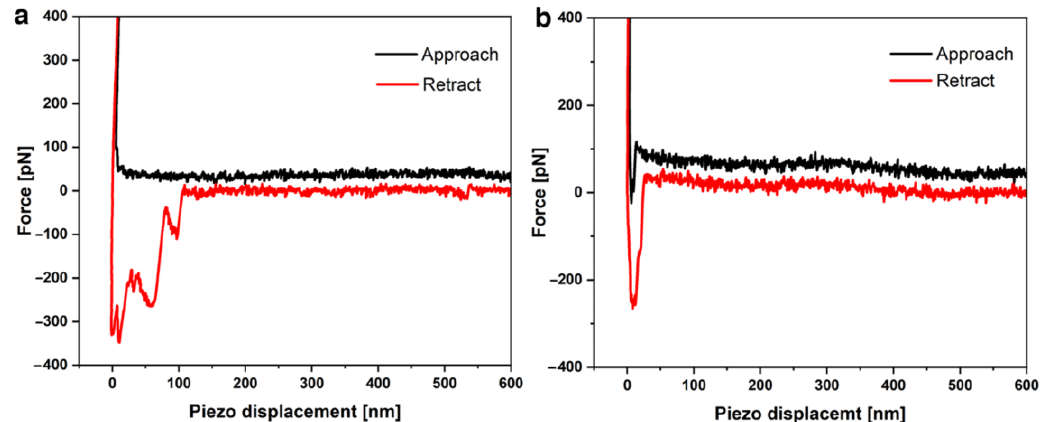
Figure 5. Single molecule force distance curves of an Imp- PM19/∆D3 -Imp-PM19 mutant functional- ized SFM-tip on the F-actin rabbit surface measured by SFM. The interactions of F-actin rabbit with the Imp-PM19 ( a ) and the ∆D3 -Imp-PM19 mutant ( b ) are represented.